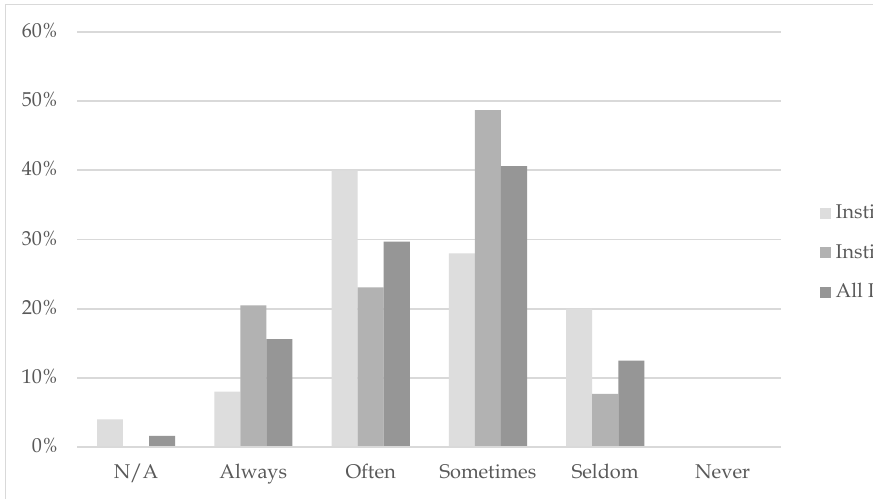
Figure 1 Librarians at my institution participate in the instruction of medical students